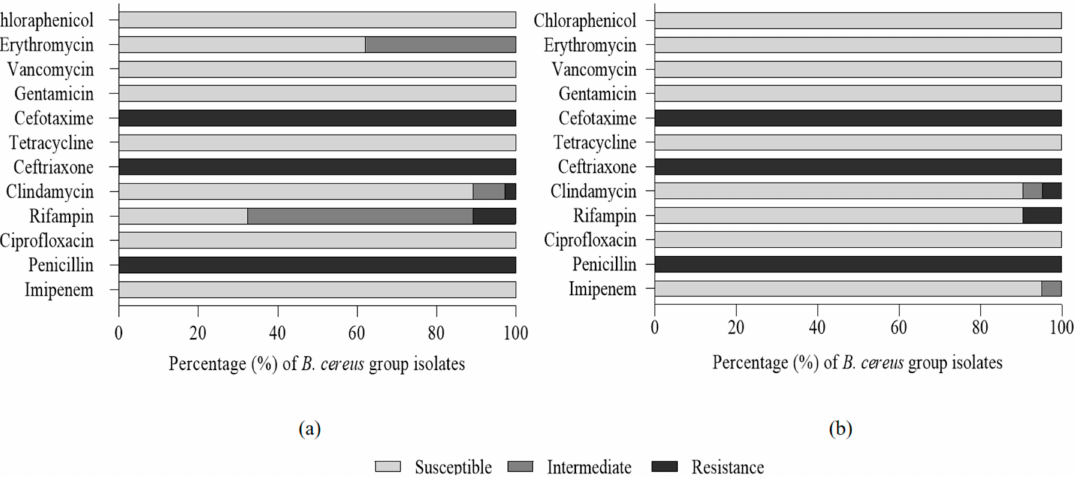
Figure 1. Antibiogram of mesophilic ( a ) and psychrotolerant ( b ) B. cereus isolates from chilled tofu. Merzouqui et al. (2014) reported that B. cereus isolated from milk, dairy products, spices, and salad with rice was susceptible to chloramphenicol (67.2%) and erythromycin (84.4%), which is consistent with the results of our study. B. cereus is generally resistant to β -lactam antibiotics, including third-generation cephalosporins due to β -lactamase- producing bacteria. Rifampicin has a bactericidal effect against microorganisms due to catalyzing the transcription of DNA to RNA, but B. cereus is frequently resistant to ri- fampicin [25,42]. In our study, 10.8% of mesophilic isolates and 9.5% of psychrotolerant isolates showed resistance to rifampicin. These results are much lower than the rifampicin resistance rate of vegetables (49–83%), rice, and cereal (62%), but higher than those of different kinds of foods, including traditional dairy products (0%) and ready-to-eat foods (0%) [15,25,43–45]. Even though the incidence of multi-antibiotic-resistant bacteria was not present in either mesophilic or psychrotolerant isolates, it is still a matter of con- cern, since antibiotic-resistant isolates may survive during gastrointestinal passage and may transfer the antibiotic resistance genes or plasmid-encoded virulent genes to